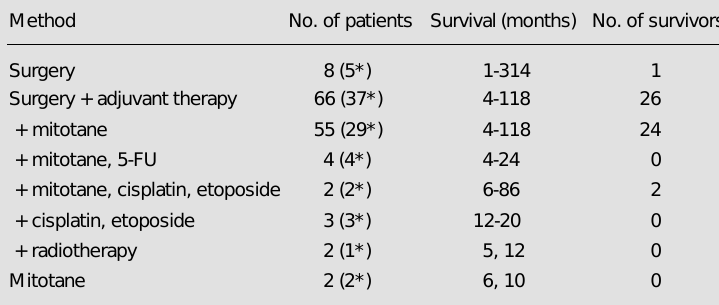
Table 2 - Results of treatment of 76 patients with adrenocortical carcinoma. *Distant or regional disease. 5-FU,